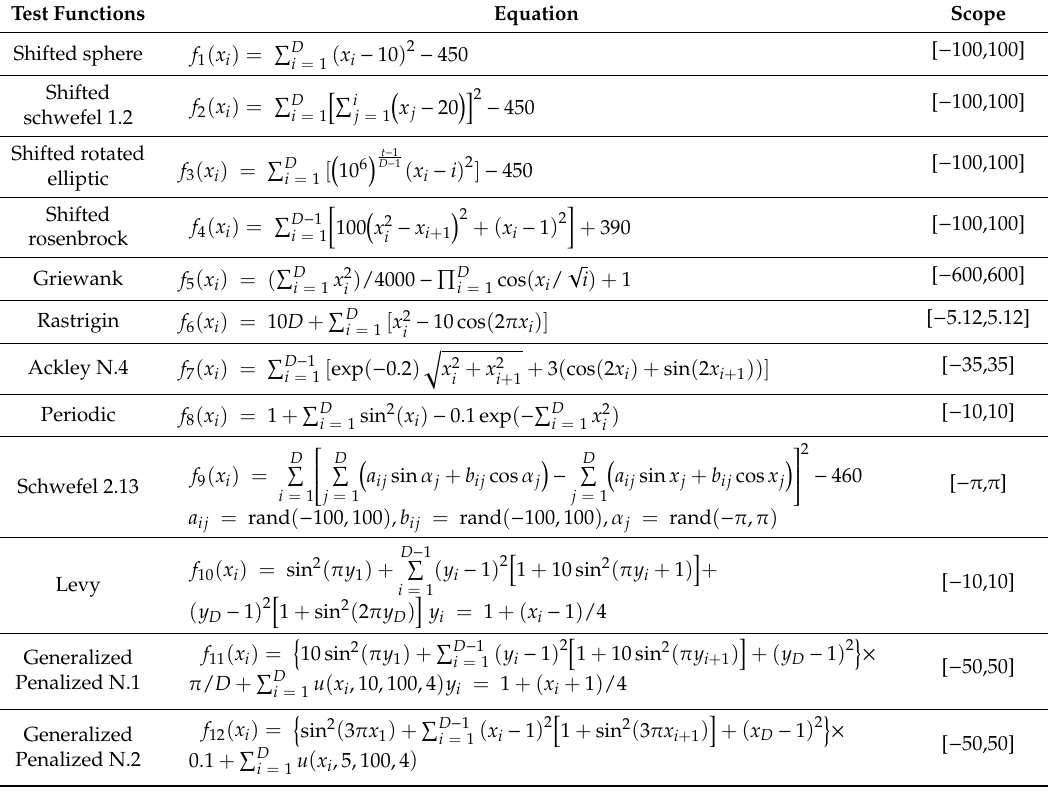
Table 1. Benchmark test